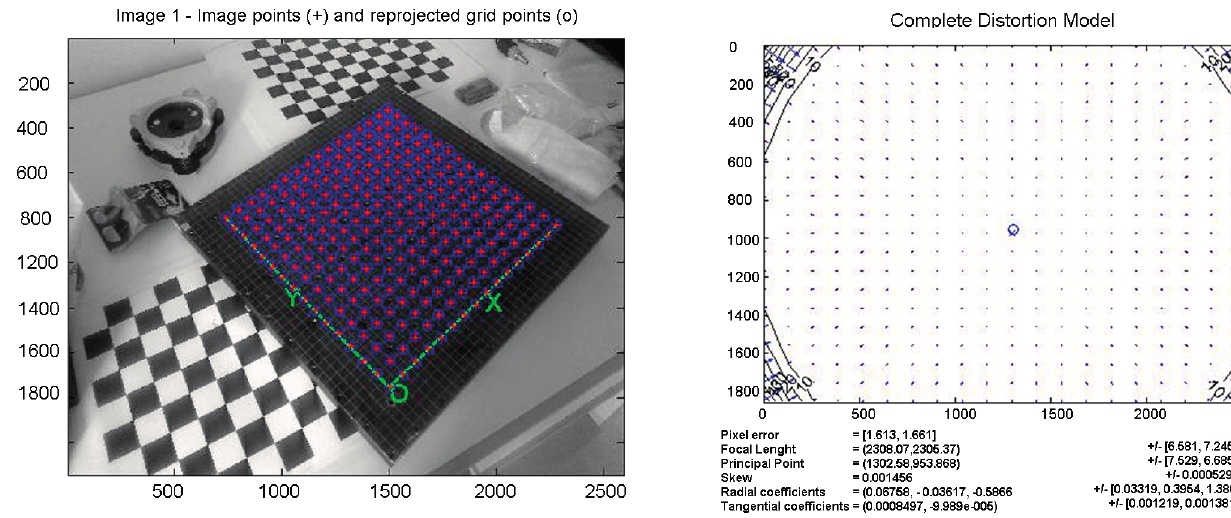
Figure 9. ( Left ) The crosses of the calibration grid are automatically recognized by the calibration software; ( Right ) the distortion model of the calibrated camera. The coordinates and the results are in